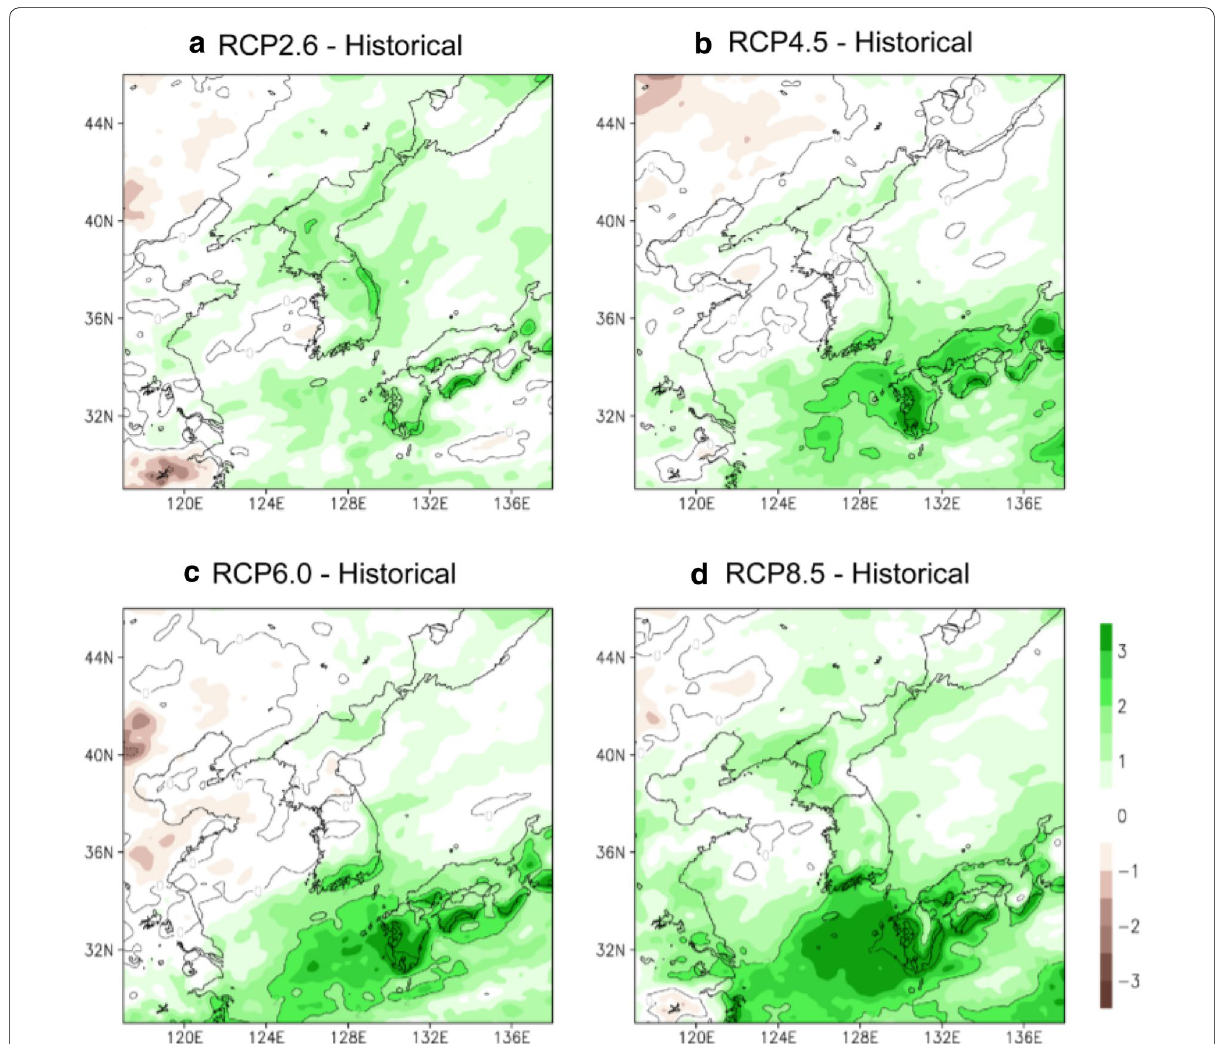
Fig. 5 Differences in summer mean (JJA) precipitation (mm day − 1 ) between future (2071–2100) and present (1981–2010) scenarios (adapted from Cha et al. (2016a,